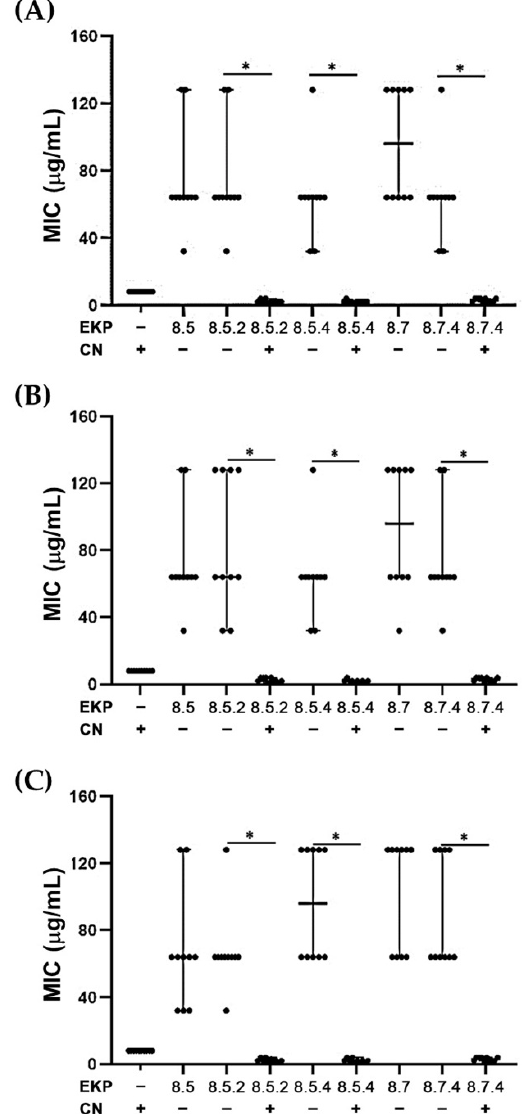
Figure 4. Scatter dot plot showing median values with 95%CI of minimal inhibitory concentration ( n = 10) of each selected purified EKP extract combined with gentamicin, which was separately tested with ( A ) CRKP, ( B ) CRPA, and ( C ) CRAB. *, Significant difference apart from CN at p ≤ 0.05. Solid lines were created after comparing the presence or absence of gentamicin with EKP extract.